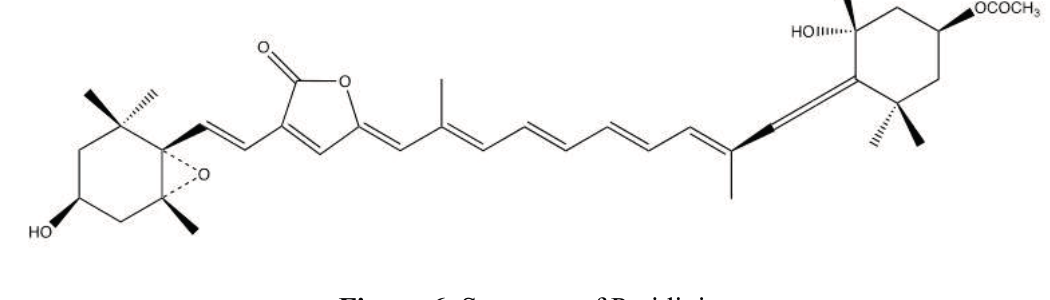
Figure 6. Structure of